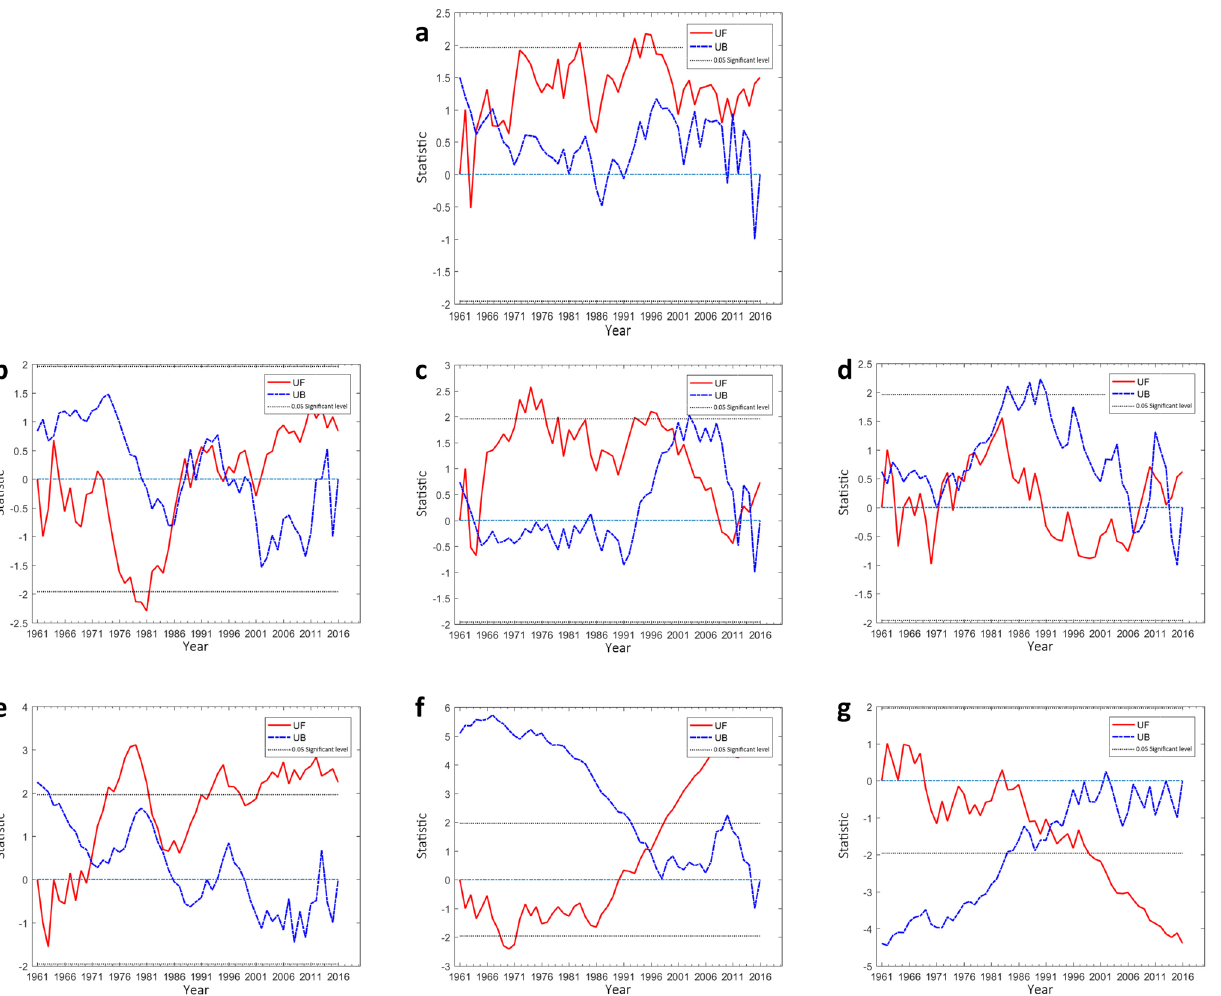
Figure 2. Mann—Kendall statistic curve of the annual and the seasonal precipitation sequence, annual average temperature sequence and area of the arid region sequence: ( a ) annual precipitation ( b ) spring precipitation ( c ) summer precipitation ( d ) autumn precipitation and ( e ) winter precipitation ( f ) annual average temperature and ( g ) area of the arid